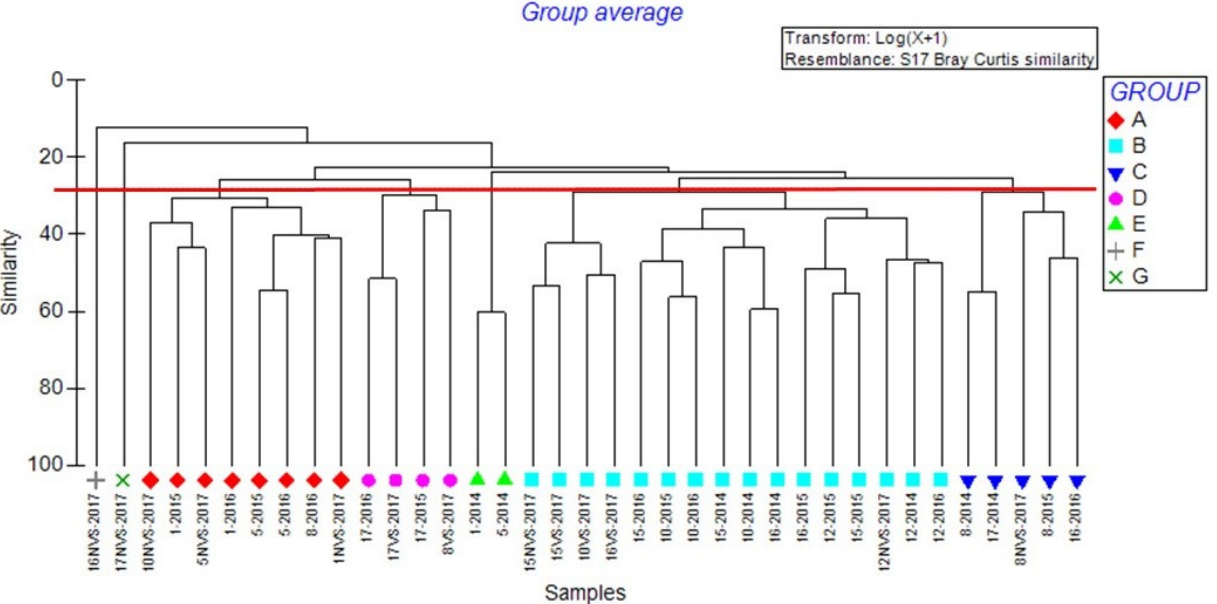
Figure 4. Cluster analysis applied to the abundance data at the eight stations sampled from 2014 ante transplantation to 2017 post-transplantation (vegetated –VS- and non-vegetated stations –NVS). In the MDS plot (Figure 5), the projection of samples of a multidimensional space is shown. On the left of the dotted line, the samples forming Groups A, D, F, and G in the cluster analysis are placed. On the right of the solid line, there are the samples of Groups C and E. Samples of Group B are placed between the two lines. In the plot, the 2014 samples are separated from the others (on the right